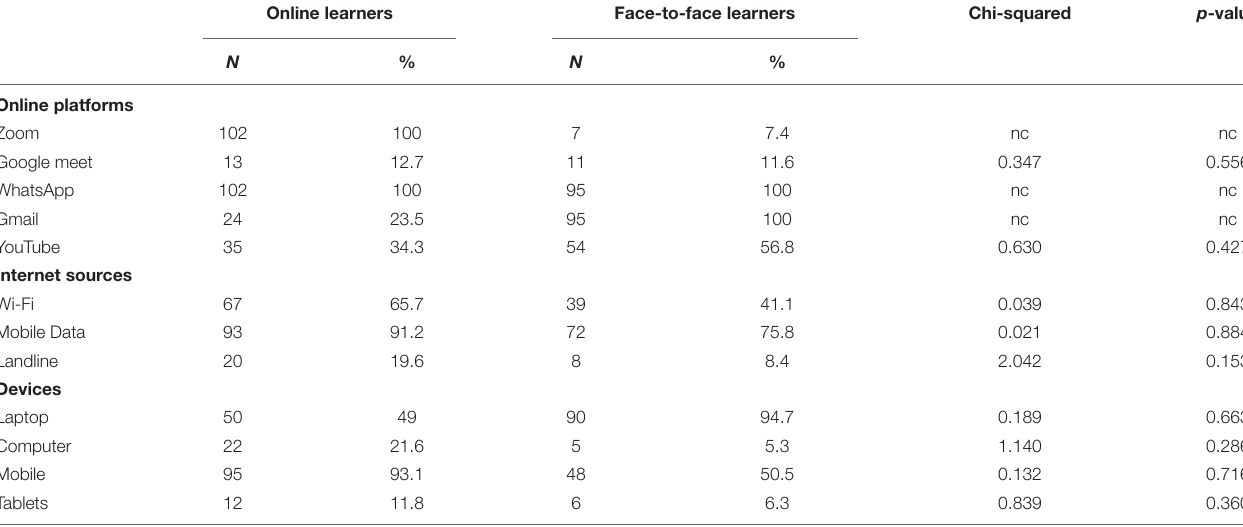
TABLE 2 | Online platforms, internet sources, and devices used by online and face-to-face